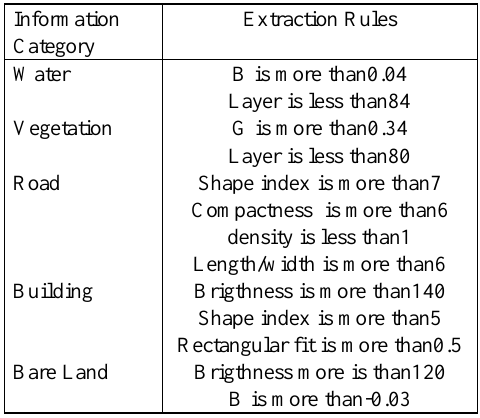
Figure 4.Water Figure 5.Vegetation